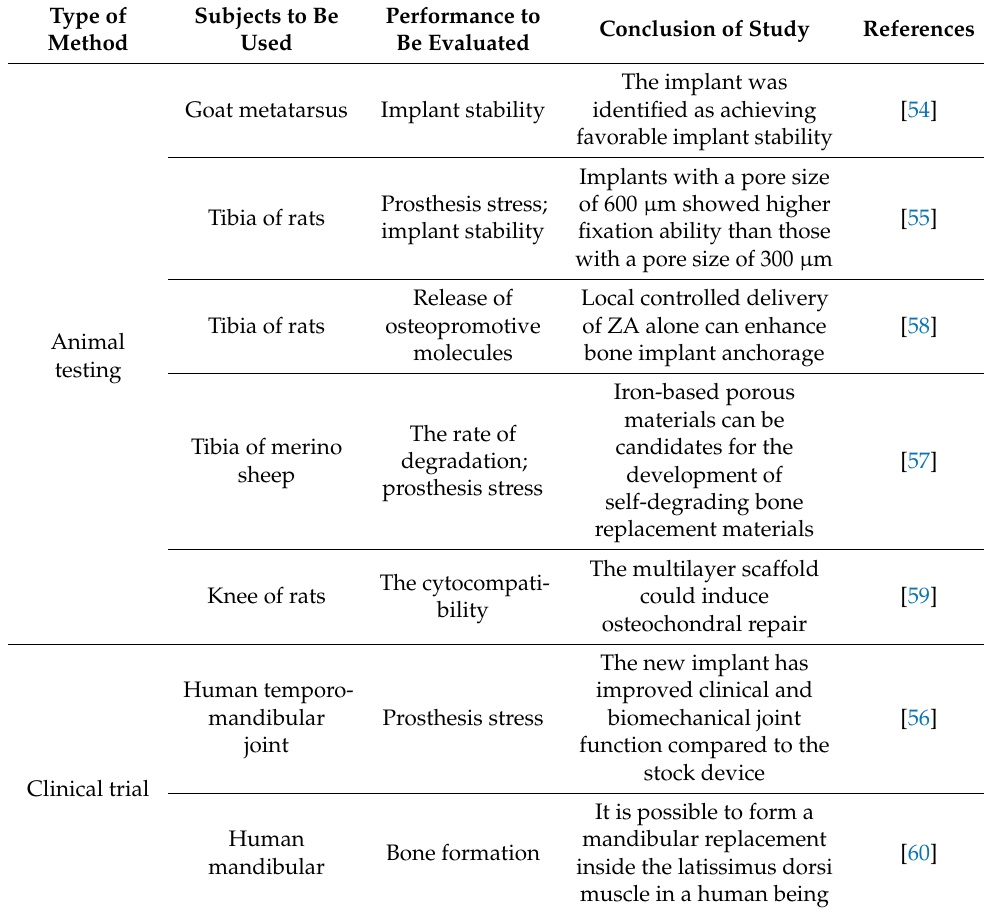
Table 8. The widely used in vivo testing methods for evaluating the performance of bone joint